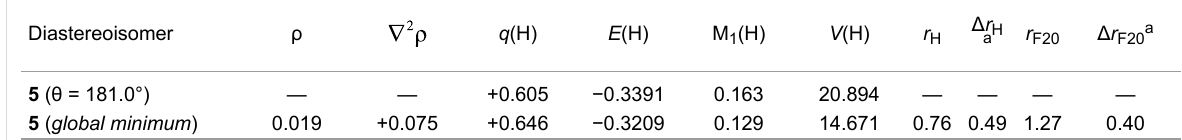
Table 2: Electronic density ( ρ ) and its Laplacian ( ) in the bond critical point (BCP) referring to the F ∙∙∙ HO intramolecular HB (HBCP), and the inte- grated properties on the H(O) atoms of the conformers of 5